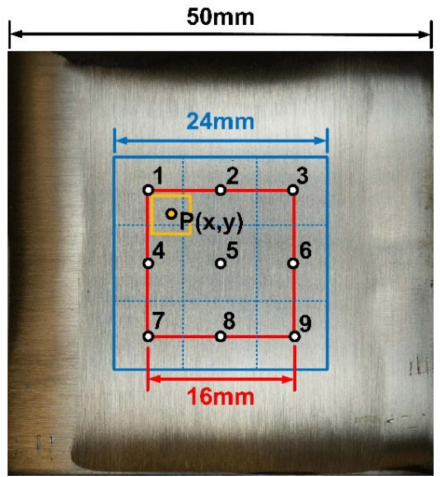
Figure 7. Data augmentation using rotation and flip.